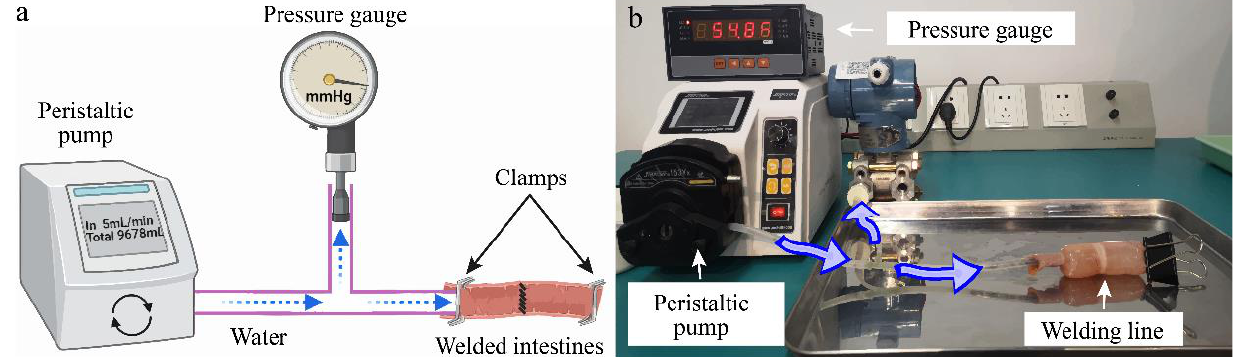
Figure 5. ( a ) Schematic diagram and ( b ) physical diagram of bursting pressure measurement device. One end of the welded small intestine is placed over the T-shaped tube, and the other end is completely sealed by a clamp. The peristaltic pump delivers water to the bowel cavity at a flow rate of 5 mL/min until the anastomosis leaks. The maximum water pressure was recorded as the bursting pressure by the pressure gauge. Bursting pressures below 15.4 mmHg (the highest peak pressure of the human ileum) are considered welding failures.